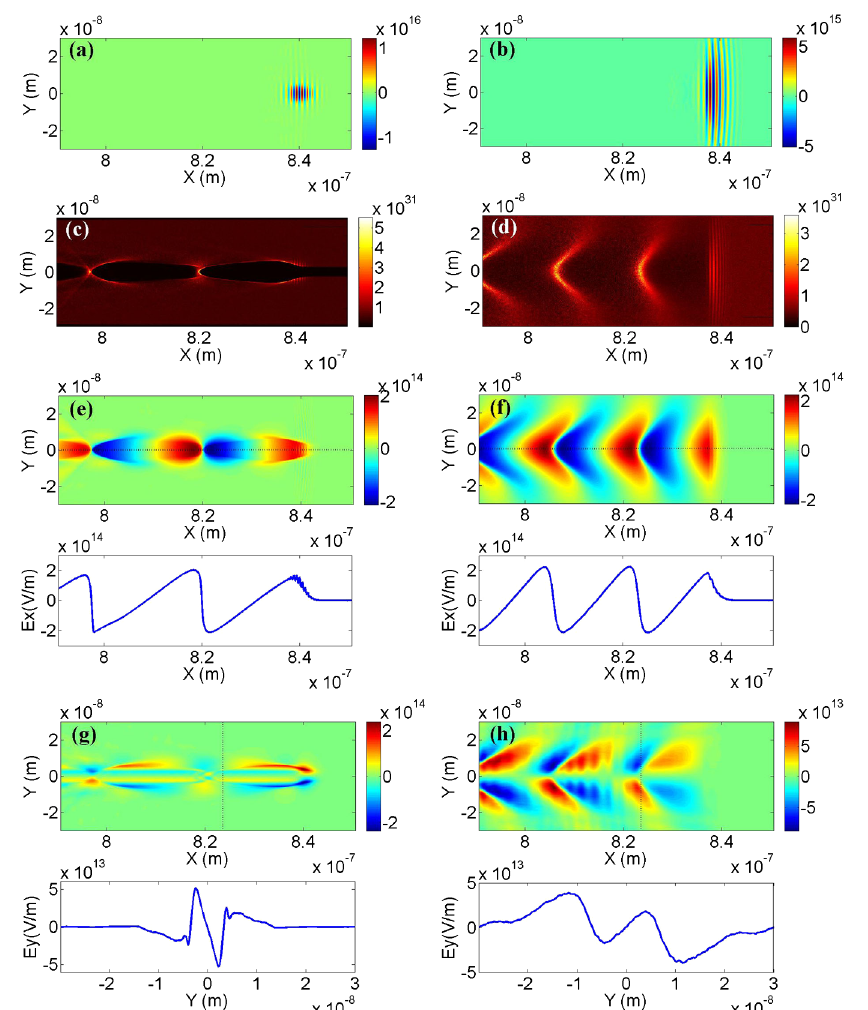
FIG. 2. The base case wakefield excitation with x-ray laser in a tube, in comparison with a wakefield in a uniform system. Distributions of (a) and (b) the laser field E z ð V = m Þ , (c) and (d) electron density n e ð m − 3 Þ , (e) and (f) longitudinal wakefield E x ð V = m Þ including the E x lineout at y ¼ 0 axis (the position of dot line), and (g) and (h) transverse wakefield E y ð V = m Þ including the E y lineout at x ¼ 8 . 24 × 10 − 7 m axis (the position of dot line) in terms of (a), (c), (e), and (g) tube and (b), (d), (f), and (h) uniform density cases driven by the x-ray pulse.